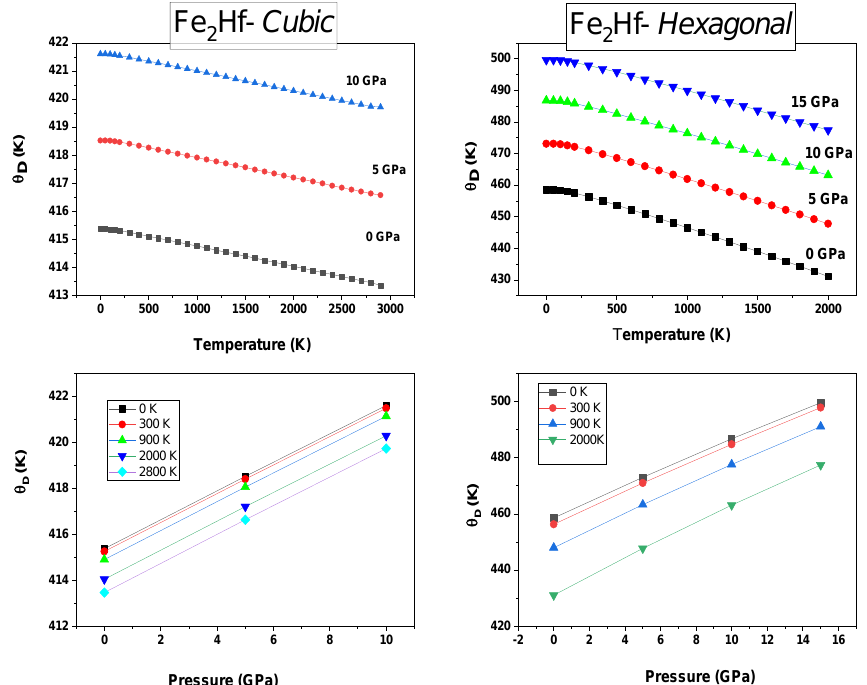
Fig. 9. Variation of Debye temperature with temperature T and pressures for c- Fe 2 Hf and h- Fe 2 Hf (upper panel),